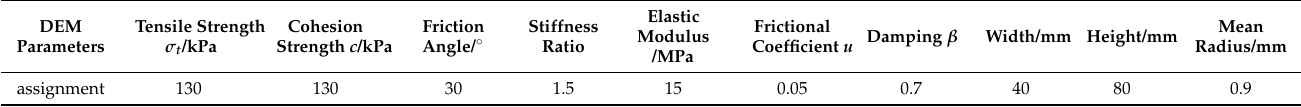
Table 3. The calibration results of undisturbed soils.